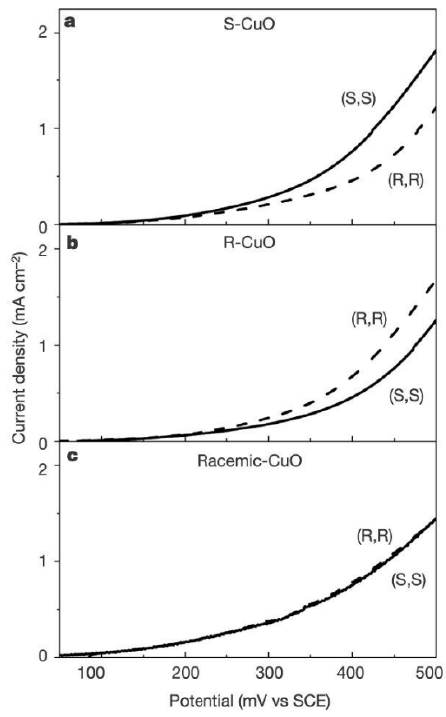
Figure 2. Enantio-recognition by electrodeposited chiral CuO. Electrocatalytic activity of chiral electrodes ( a ) (S)-CuO, ( b ) (R)-CuO, and ( c ) (racemic)-CuO films towards oxidation of (R,R) and (S,S) tartaric acid (Reproduced with permission from [19], Nature Publishing Group, 2003).